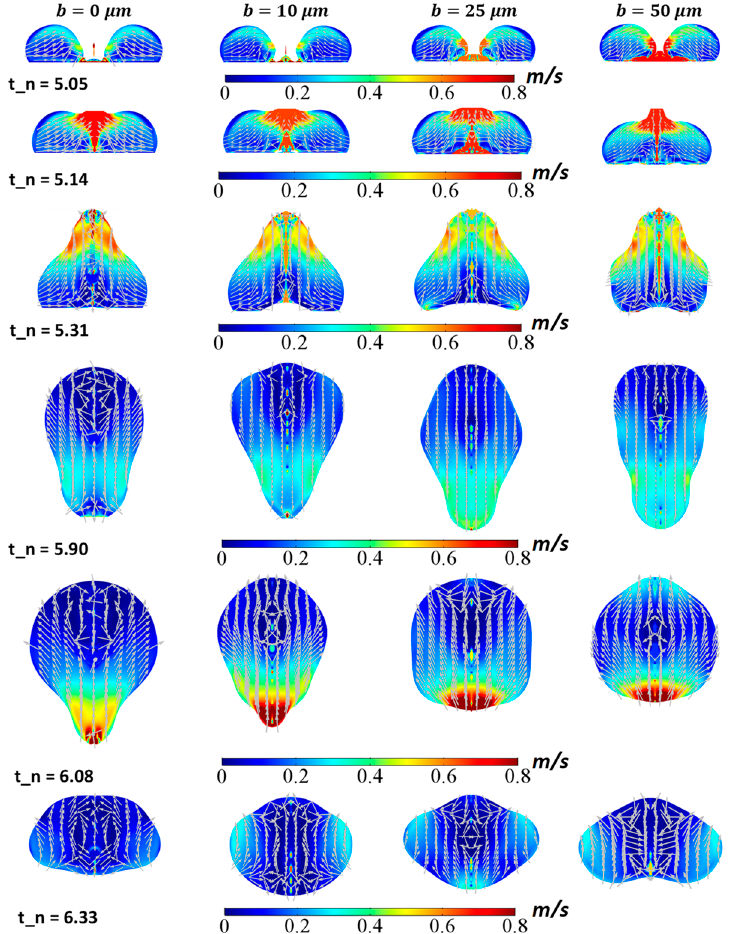
Figure 11. Velocity field developed inside droplet fluid during retracting and rebound initiation periods for various micro ‐ post spacings. Droplet volume is 10 μ L and impact height is 20 mm. The micro ‐ post spacing b = 0 represents the flat hydrophobized surface.